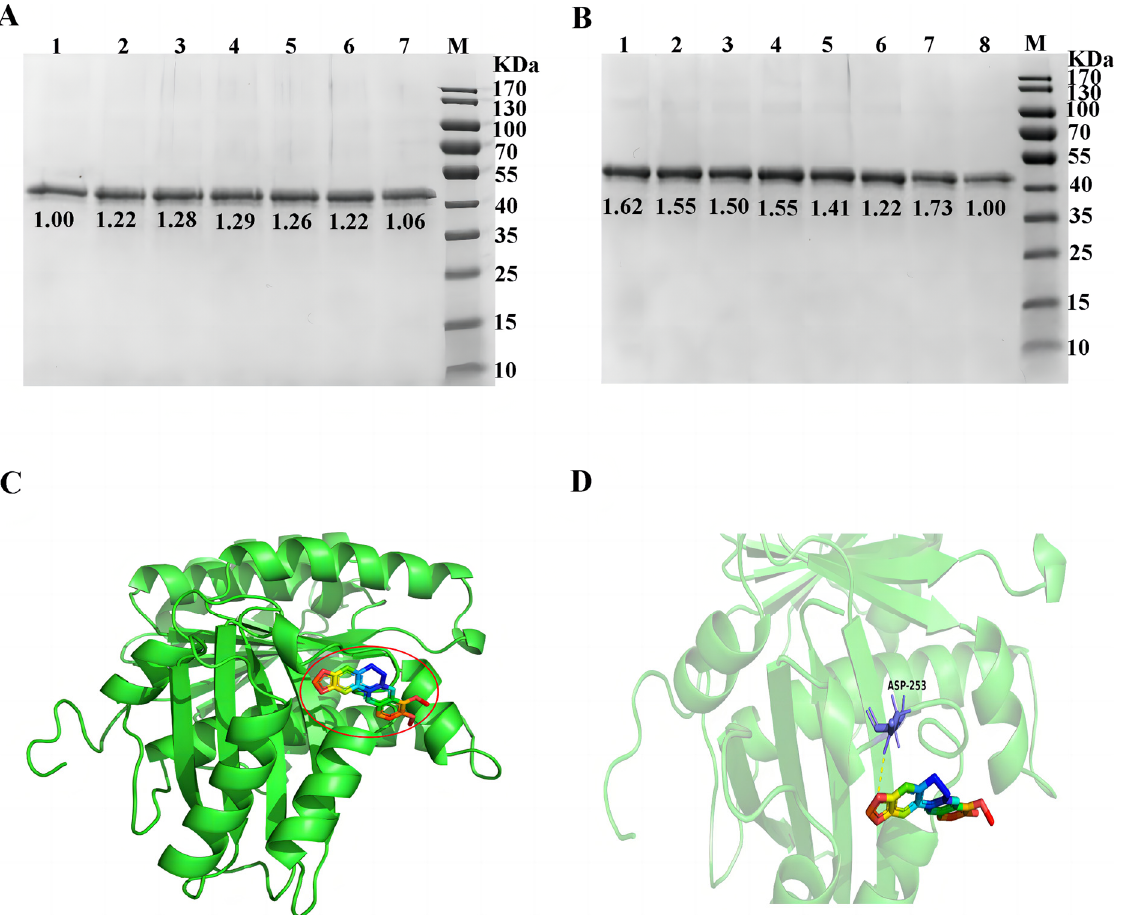
Figure 4. Interaction of berberine hydrochloride and the recombinant FtsZ protein. ( A ) Effects of different concentrations of GTP on FtsZ aggregation. Lane 1: 0 mM GTP; lane 2: 0.25 mM GTP; lane 3: 0.5 mM GTP; lane 4: 1 mM GTP; lane 5: 2 mM GTP; lane 6: 4 mM GTP; lane 7: 8 mM GTP; M: marker. Lane numbers indicate the relative intensity of the bands. ( B ) Effect of berberine hydrochloride on FtsZ aggregation. Lane 1–3: berberine hydrochloride was first incubated for 30 min with FtsZ protein and then incubated for another 30 min with GTP; lane 4–6: berberine hydrochloride was incubated directly with FtsZ protein and GTP for 1 h; berberine hydrochloride concentrations were 1.56 (lane 1 and 4), 6.25 (lane 2 and 5), and 25 (lane 3 and 6) µg/mL; lane 7: FtsZ and GTP solution; lane 8: FtsZ solution; M: marker. Lane numbers indicate the relative intensity of the bands. ( C , D ) Binding of berberine hydrochloride to FtsZ. Molecular docking was performed by using AutoDock software to analyze the binding of berberine hydrochloride (a ligand) to FtsZ (receptor).